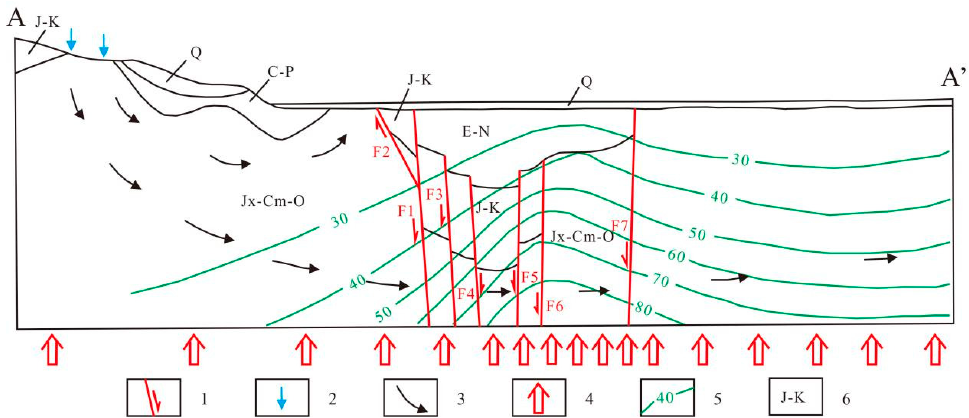
Figure 4. Sketch profile showing formation of the thermal groundwater, section location is indicated in Figure 4. 1—Fault; 2—Rainfall; 3—Flowing direction of thermal groundwater; 4—Terrestrial heat